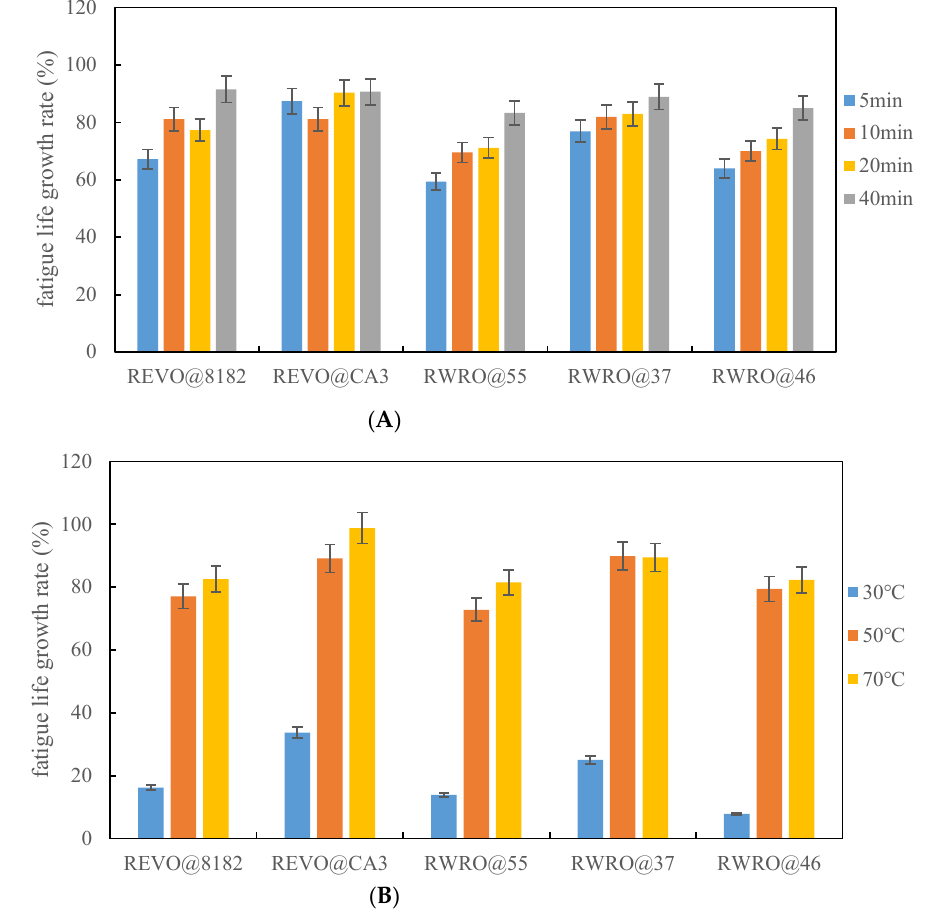
Figure 14. ( A ) Effect of healing time on fatigue life of rejuvenated asphalt. ( B ) Effect of healing temperature on fatigue life of rejuvenated asphalt.